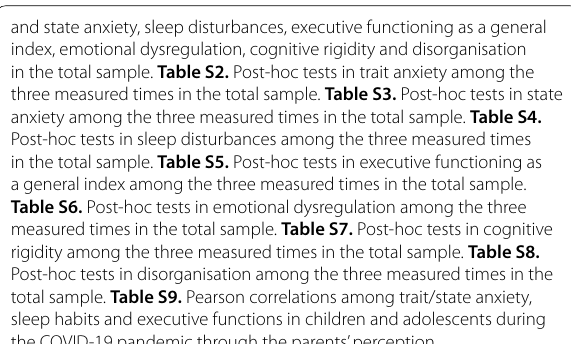
total sample. Table S9. Pearson correlations among trait/state anxiety, sleep habits and executive functions in children and adolescents during the COVID‑19 pandemic through the parents’